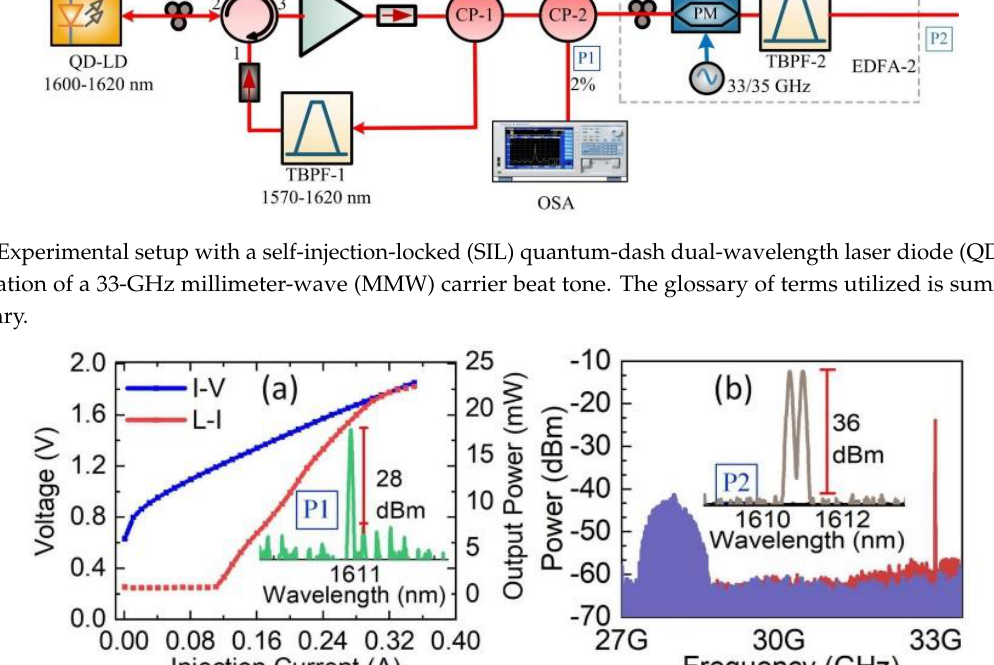
Figure 2. ( a ) Light output–injected current–measured voltage (L–I–V) characteristics of the free-running quantum-dash laser diode (QD-LD) with the inset depicting the single SIL mode at ~1610 nm with a 28 dB side-mode-suppression ratio (SMSR), at location P1 of Figure 1. ( b ) Electrical signal of the 33 GHz MMW carrier generated by the beating of the two optical tones of the QD-DWL and the 28 GHz MMW carrier electrical signal generated by the beating of the optical carrier with a sideband, observed at location P3 and R1 in Figure 3. The inset of ( b ) depicts the dual modes of the SIL QD-DWL.